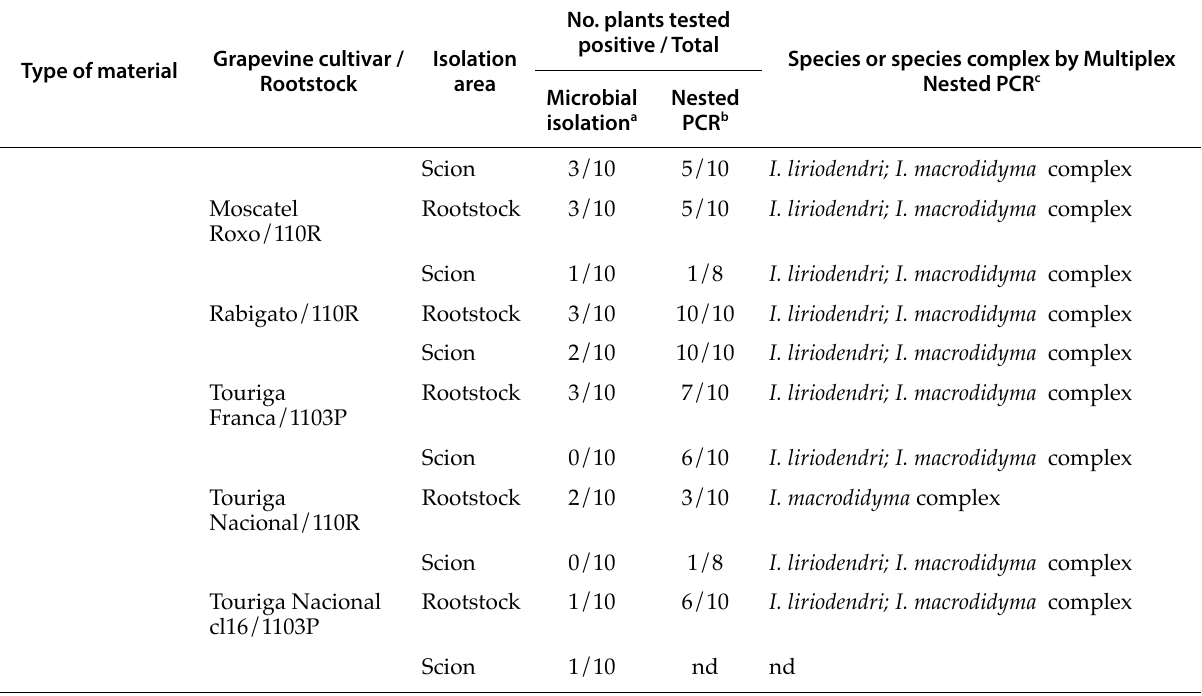
Table 1. Continues.